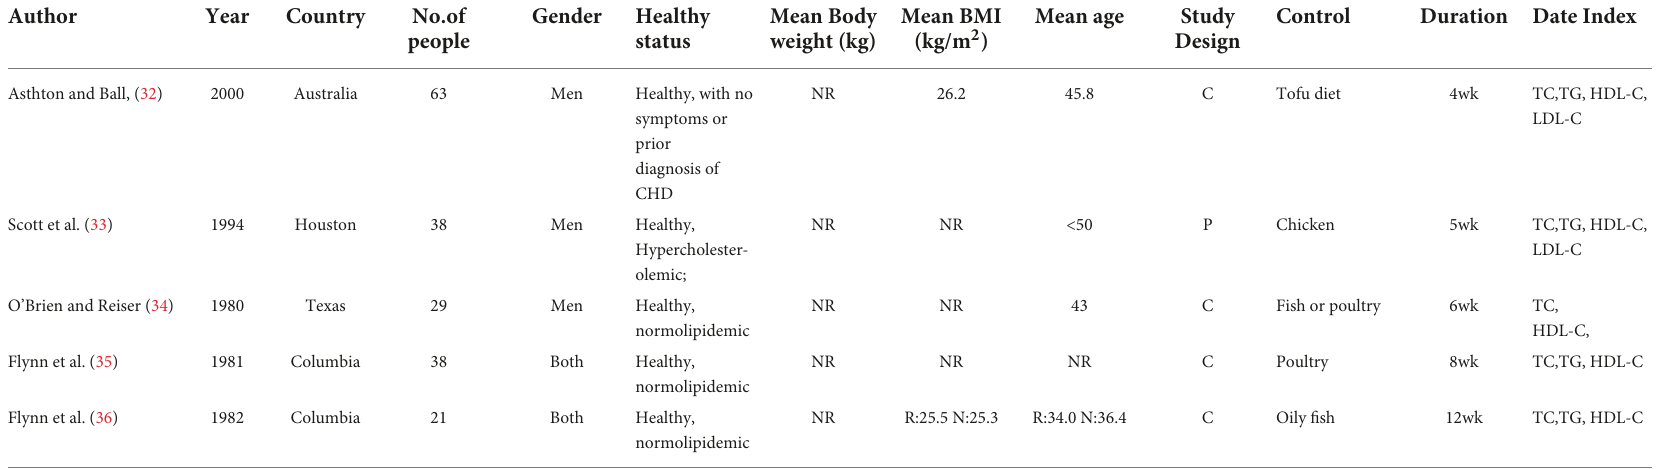
TABLE 2 Characteristics of the 20 RCT studies